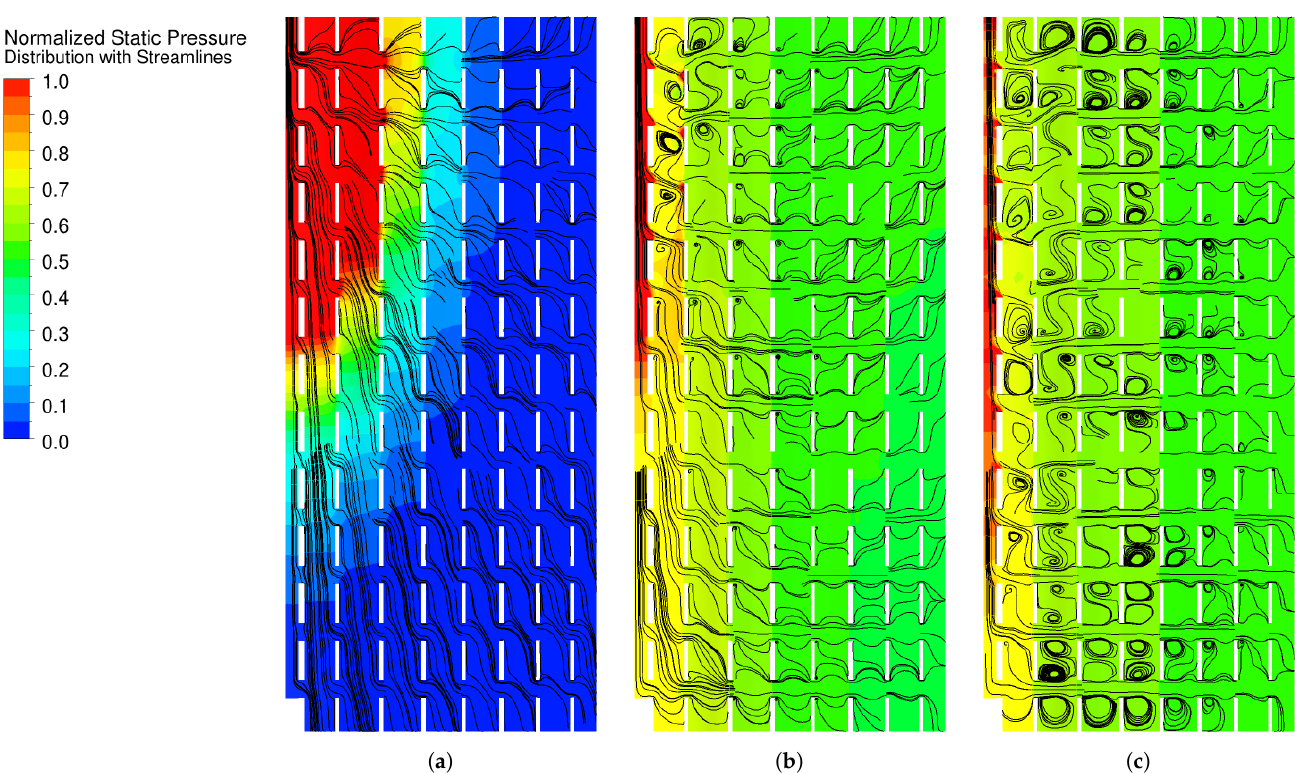
Figure 7. Normalized static pressure distribution for the fast filling process in x-z plane view at different time steps: ( a ) t = 0.001s. ( b ) t = 0.005s. ( c ) t =